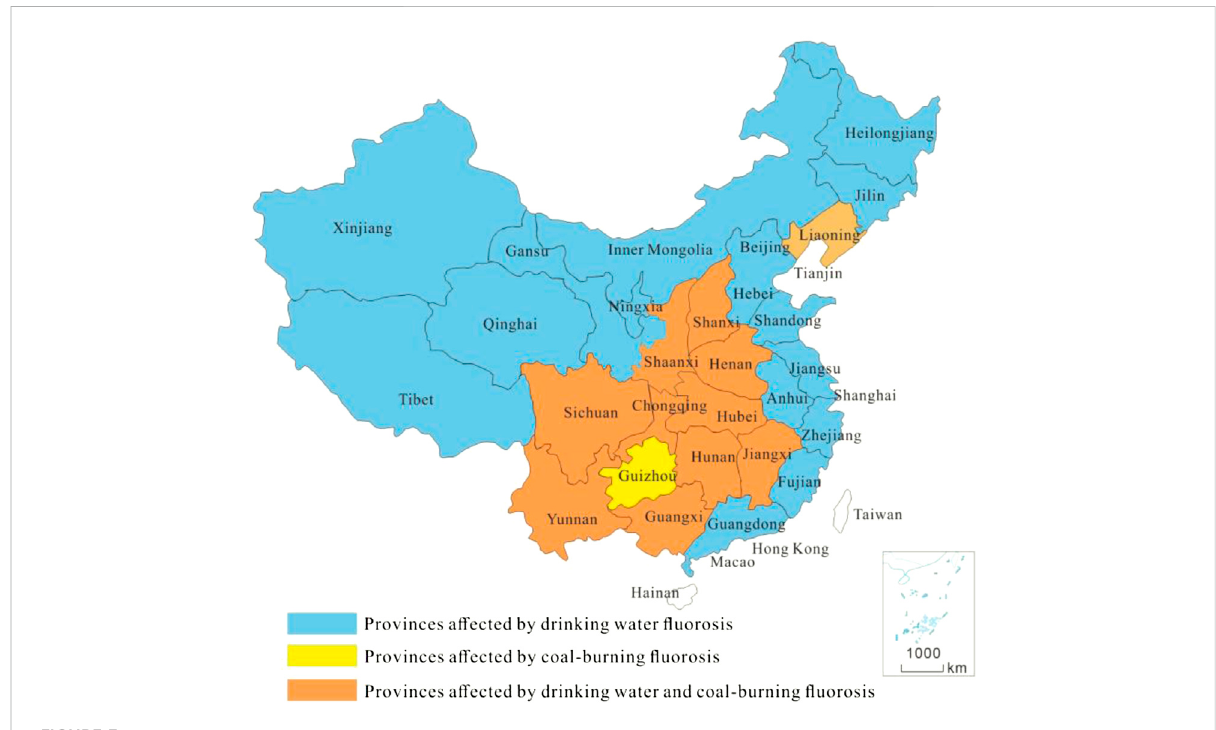
FIGURE 3 Provinces affected by drinking water fl uorosis in various provinces in China (2017